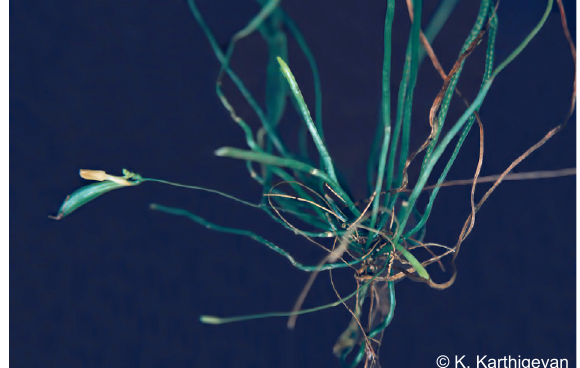
Image 1. Taeniophyllum filiforme habit